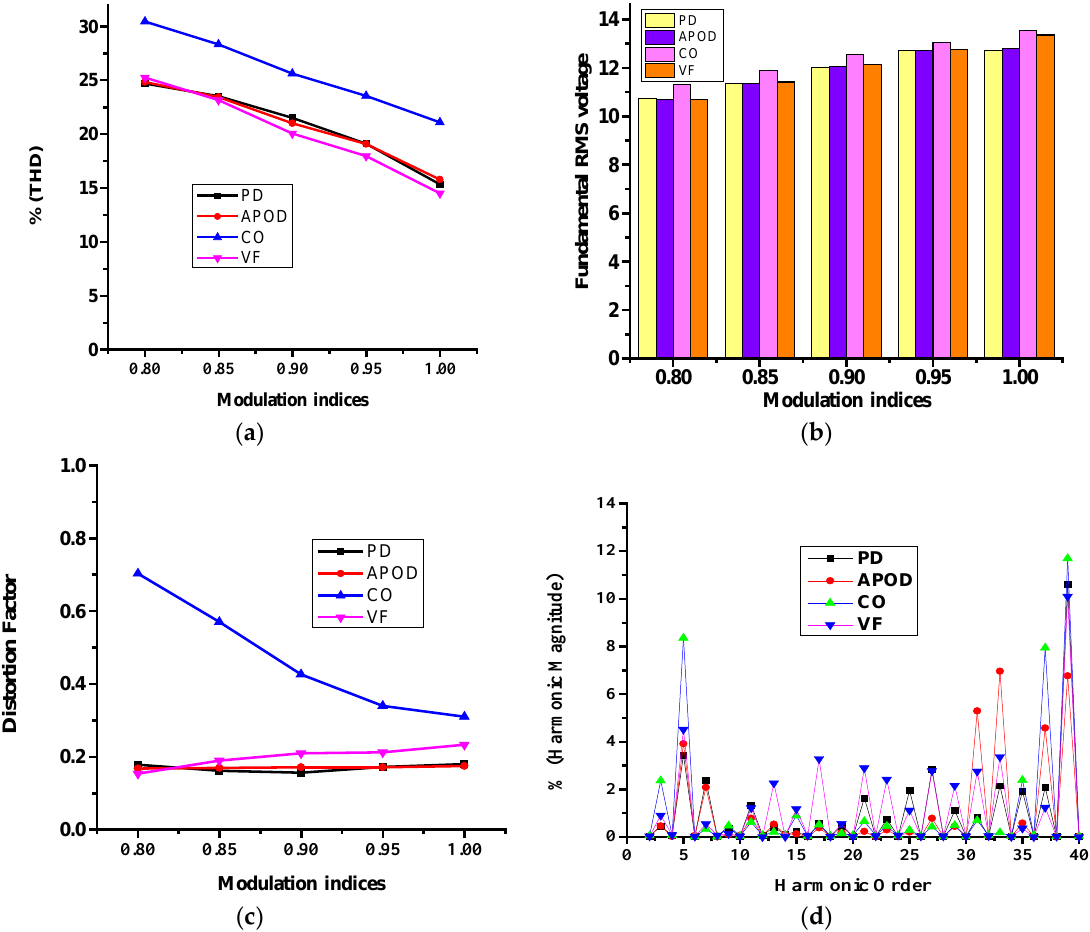
Figure 15. Different parameters for different modulation indices by simulation results: ( a ) %THD; ( b ) V RMS ; (c) %DF; ( d ) %Harmonic content for different harmonic orders.